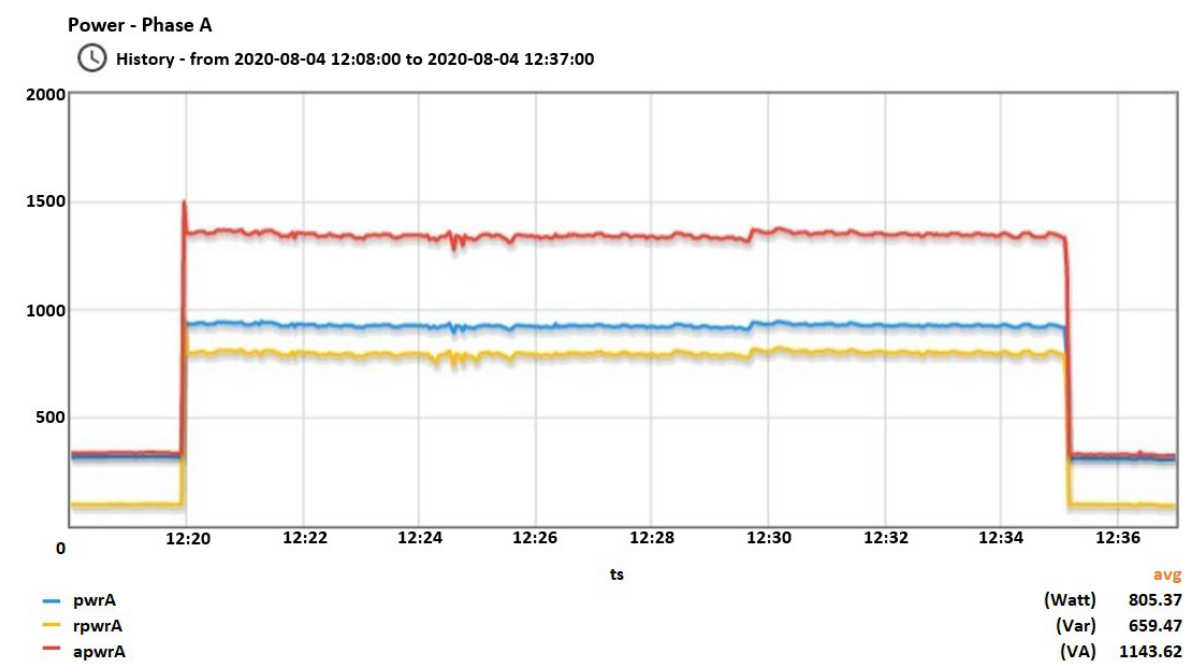
Figure 10. Vacuum’s total consumption from the beginning of its function until the end. Vacuum operated in a time period where no other device changed the state.